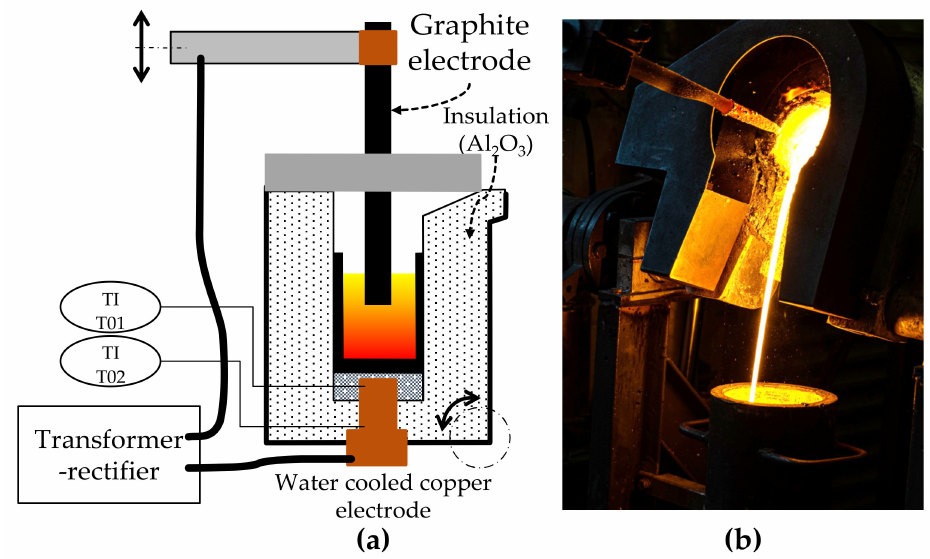
Figure 2. Laboratory electric arc furnace: ( a ) Schematic concept of the furnace; ( b ) tapping of the furnace after an